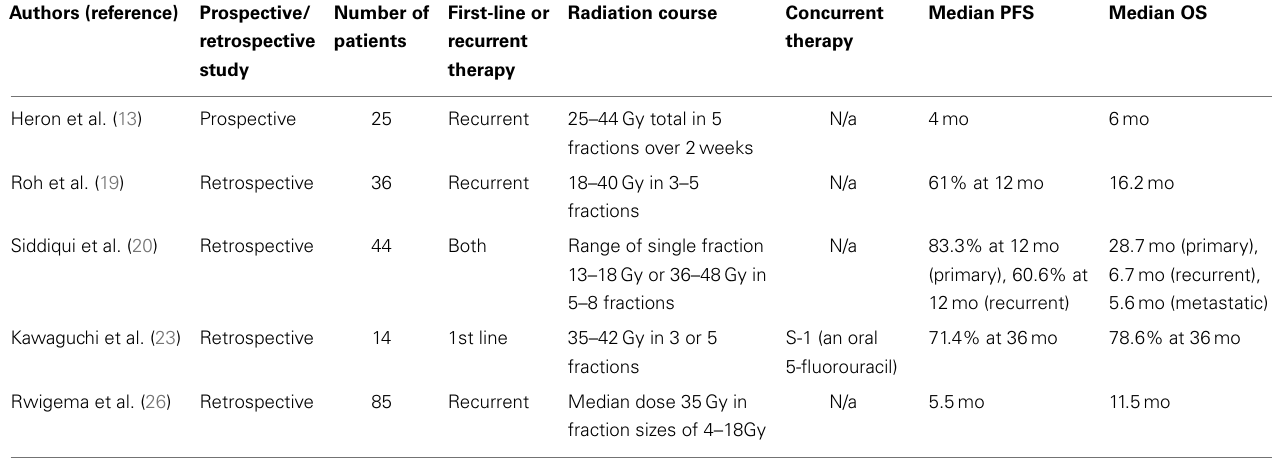
Table 2 | Review of SBRT for head and neck cancers